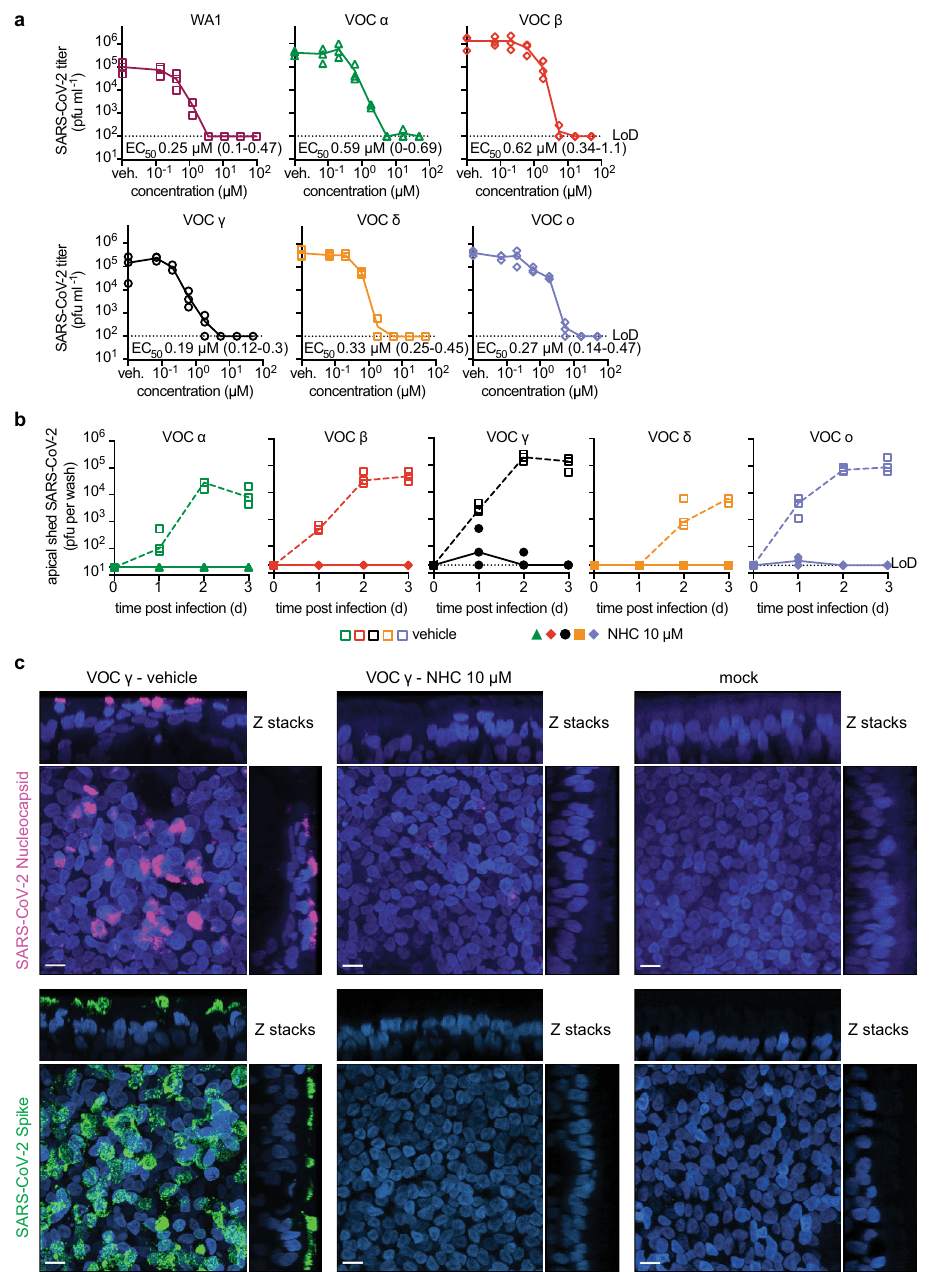
Fig. 1 | Ef fi cacy of NHC against VOC in cultured cells and primary HAEs. a NHC dose-responseassaysagainstSARS-CoV-2WA1andVOCalpha,beta,gamma,delta, and omicron on VeroE6-TMPRSS2 cells. EC 50 values from non-linear regression modeling are shown with 95% con fi dence intervals in parenthesis. b Activity of 10 µ M basolateral NHC administered against VOC as in a on well-differentiated primary HAE organoids. Apically shed virus was harvested every 24hours during a 3-day period after infection. a , b represent independent biological repeats, lines intersect group means. LoD limit of detection. c Confocal microscopy of primary